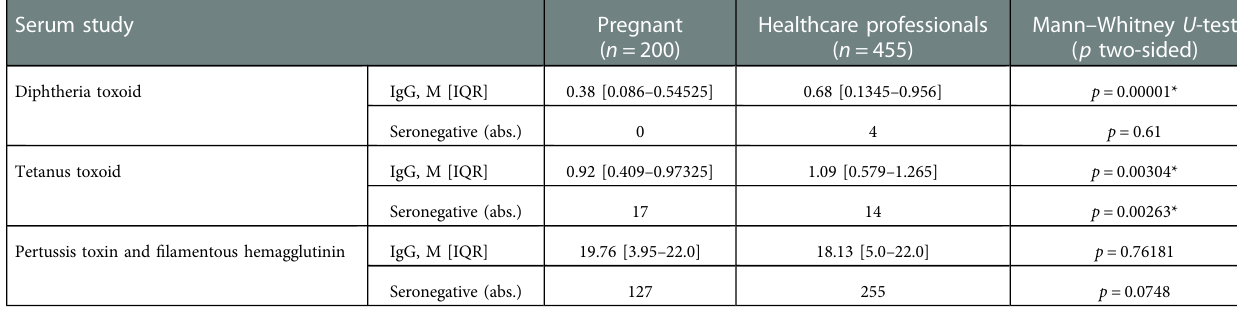
TABLE 8 IgG blood serum levels to diphtheria, tetanus, and pertussis in pregnant women and healthcare professionals. Serum